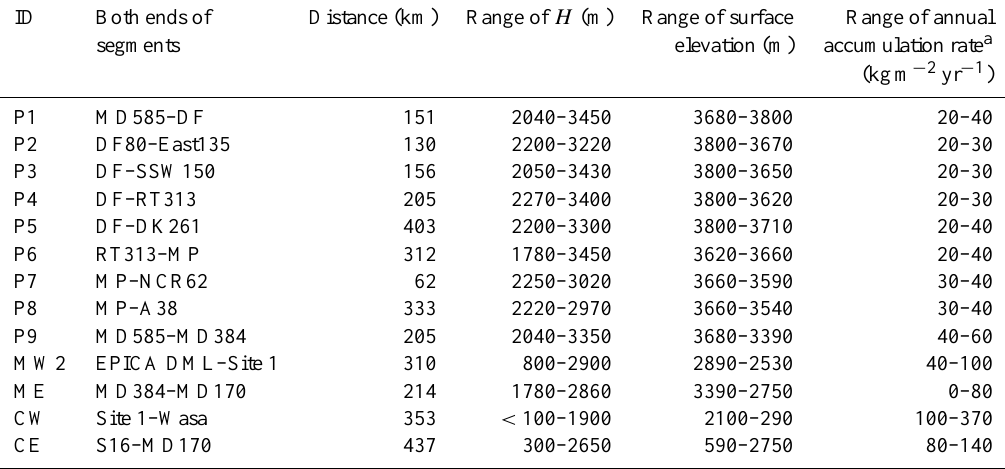
Fig. 2. Cross-sectional plot of the ice sheet. Labelled legs are discussed herein. The abscissa indicates the horizontal distance along the profiles, and the ordinate indicates the elevation above the WGS84 ellipsoid. The vertical exaggeration is approximately 500 times. The locations of major sites are shown as vertical dashed lines. The bed elevation (red, blue, and green) was calculated from the surface elevation data and ice thickness data extracted from the radar sounding data (Fujita et al., 1999, 2011), and where this dataset does not show the bed reflection, the data with thick black dashed lines are from Huybrechts et al. (2009). The red, blue, and green traces are predicted temperate bed, frozen bed, and uncertain (or intermediate) bed conditions, respectively, as the diagnosis result of the present work. Table 2. Segments analyzed in this